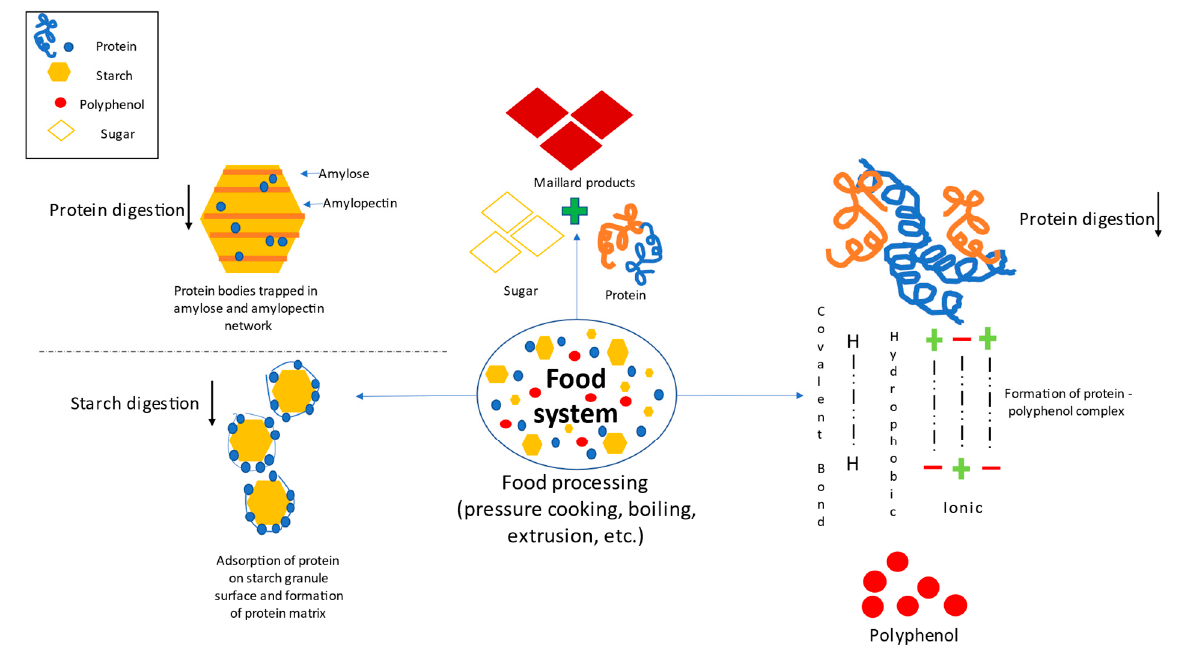
Figure 3. P rotein-polyphenol, protein-starch and protein-sugar interaction. Figure 3. Protein-polyphenol, protein-starch and protein-sugar